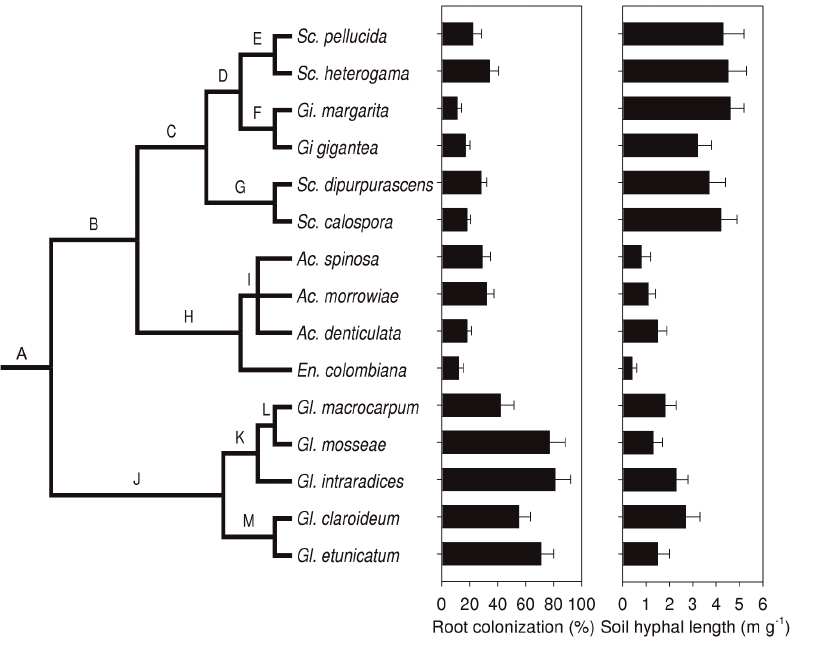
Figure 3. A phylogeny of AM fungi found in the 50 m 6 50 m sampling grid, along with trait values for Root Colonization and Hyphal Length mapped to each taxon. Both traits were phylogenetically conserved.